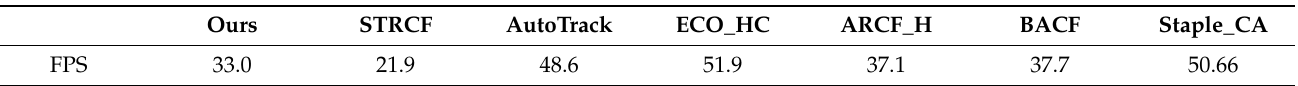
Table 9. Comparison of processing speed between the proposed method and other state-of-art object tracking methods on the DTB70